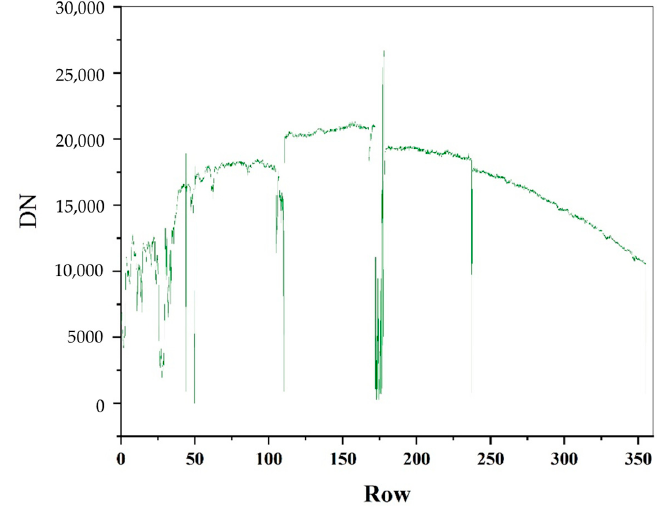
Figure 18. Mean value change of interferogram during one day measurement.